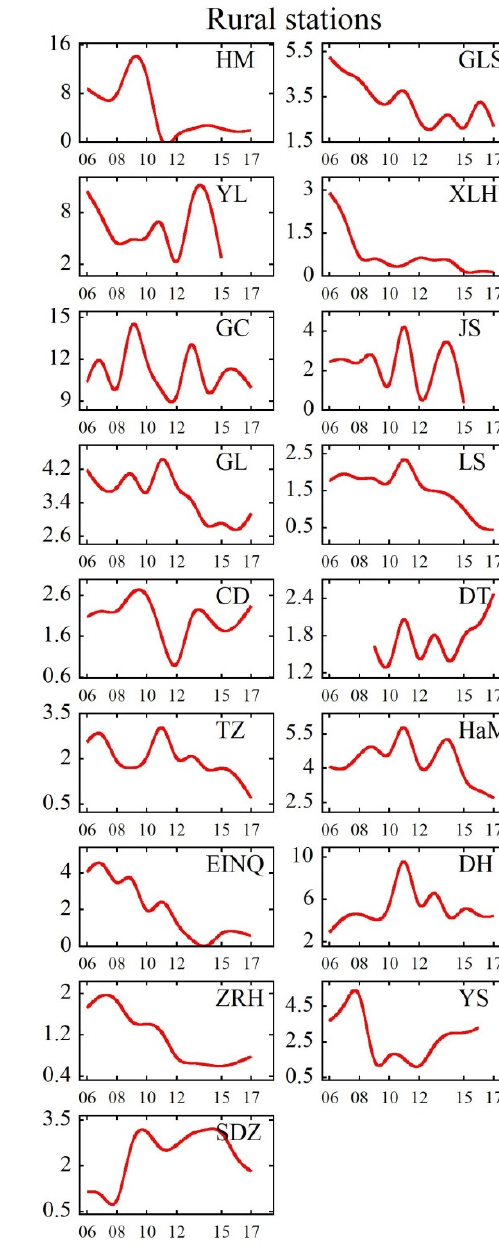
Figure 6. Annual average variation of BC concentration at each site, unit: µ g m − 3 , the X-axis sequence from 2006 to 2017, which are abbreviated as the last two digits.